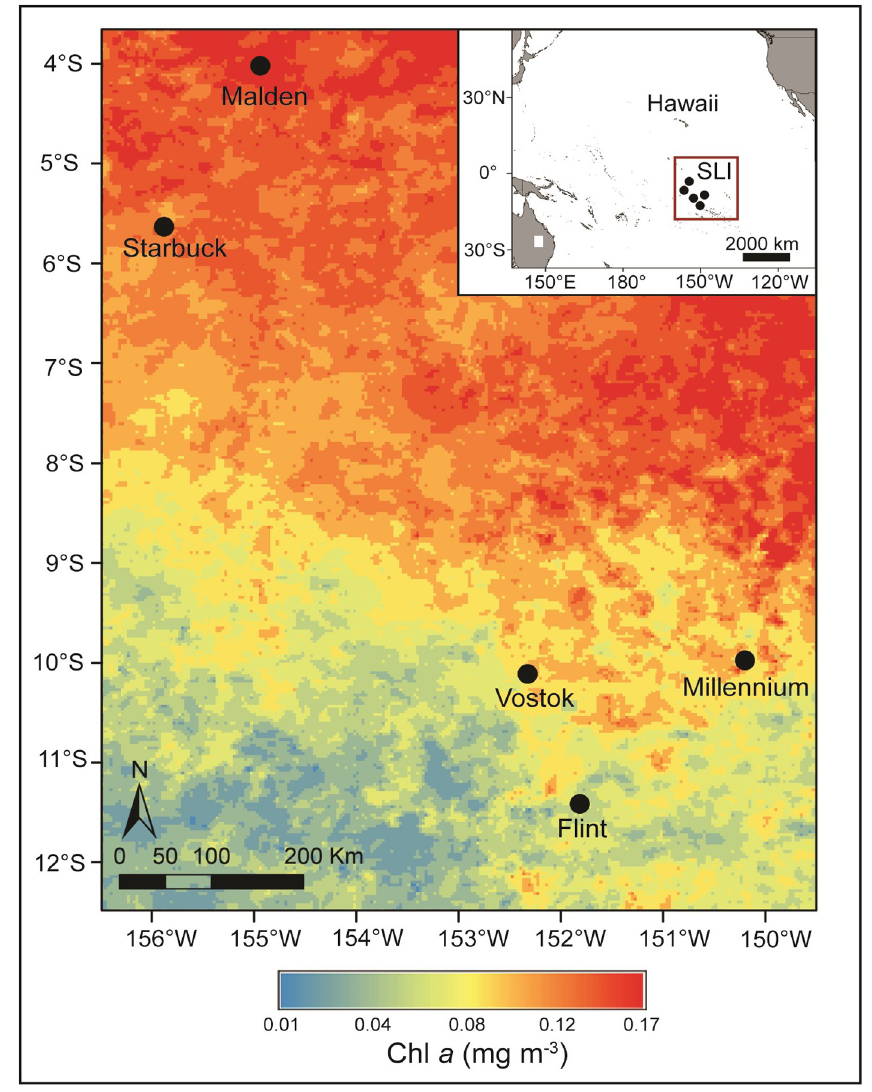
Fig 2. Surface-ocean chl a during cruise. Average surface-ocean chl a concentrations increased from south to north across the Southern Line Islands over four months encompassing the research expedition. Surface chl a (mg mg -3 ) was estimated from the eight-day 0.0417˚ (4 km) spatial resolution product derived from the Moderate Resolution Imaging Spectroradiometer, and concentrations ranged from 0.01 (blue) to 0.17 mg mg -3 (red) across the archipelago. incubations (S2 Table). DIN was ~350% higher at Malden (4.63 ± 0.13 μ M) versus Flint (0.46 ± 0.01 μ M) in 2013, and ~200% higher than at either Vostok (0.93 ± 0.05 μ M) or Millen- nium (0.95 ± 0.08 μ M) (Table 1). Concentration of DIP was 75–150% higher at the northern